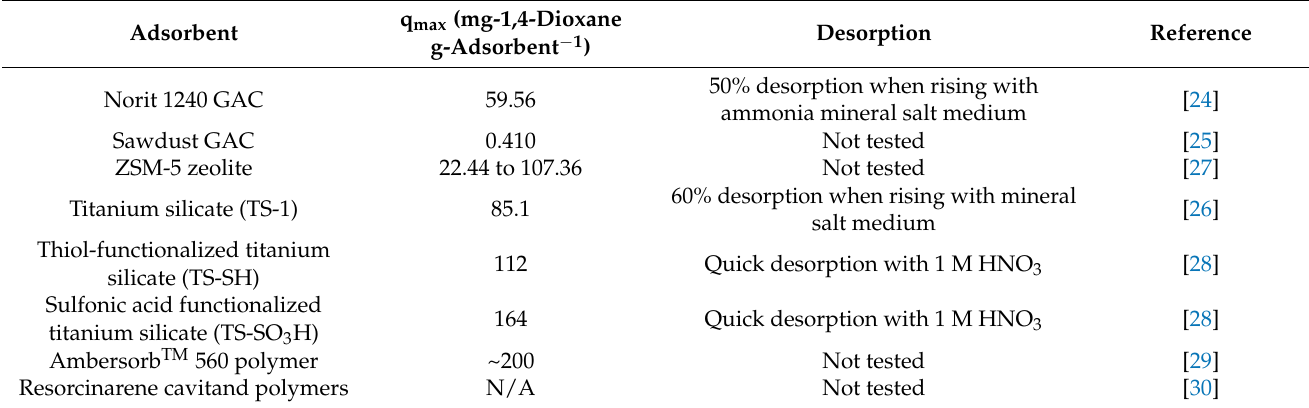
Table 2. Adsorption and desorption characteristics of proposed materials for 1,4-dioxane